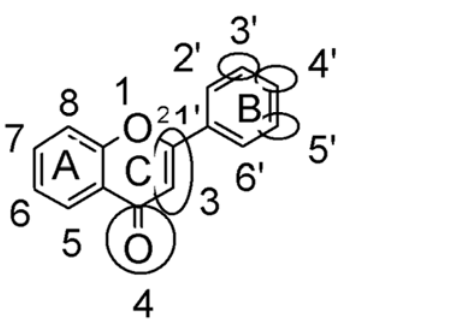
Figure 2. Chemical structure of flavones.